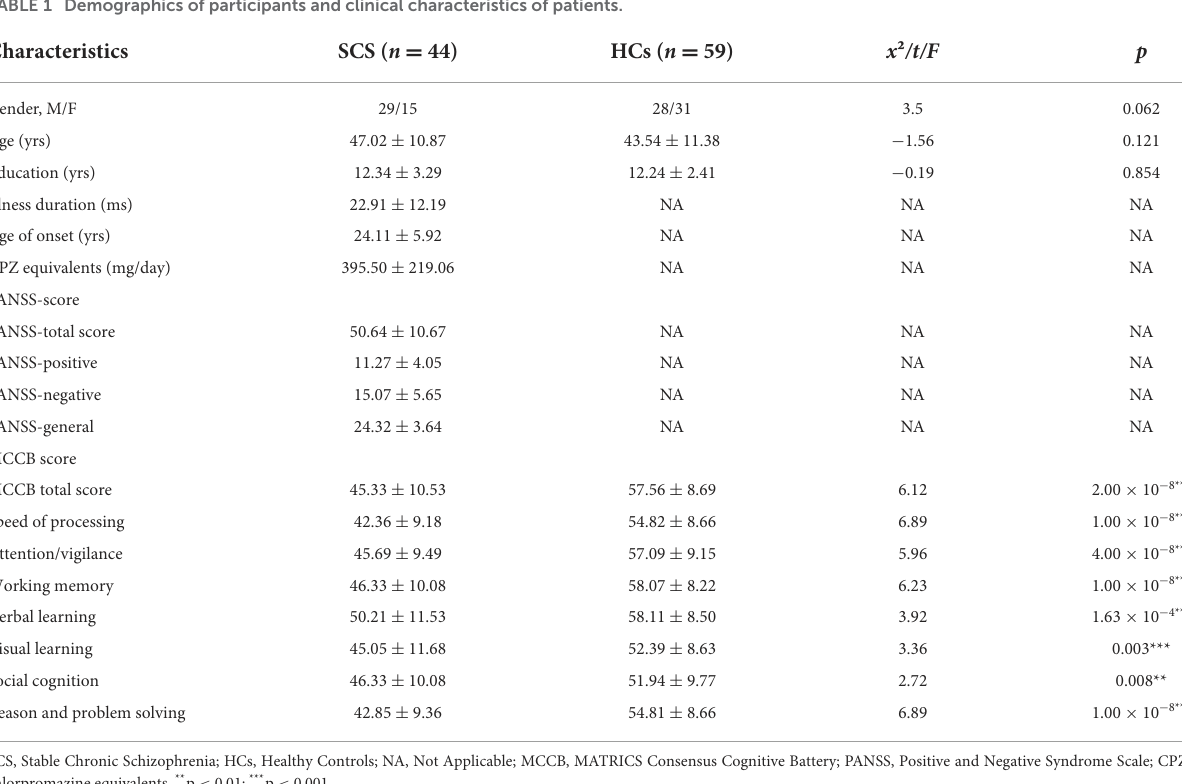
TABLE 1 Demographics of participants and clinical characteristics of patients.